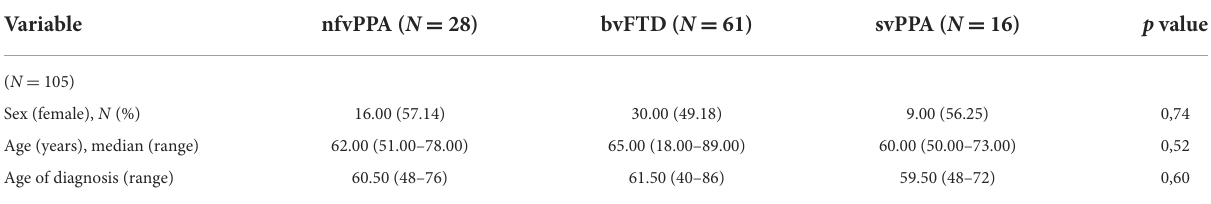
TABLE 2 Sociodemographic characteristics.